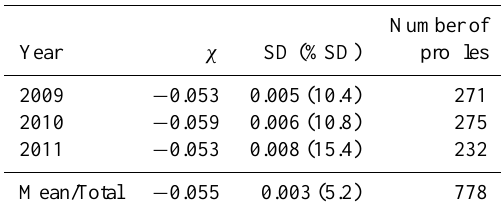
Table 1. Mean χ values together with their SD (%SD) and the num- ber of profiles